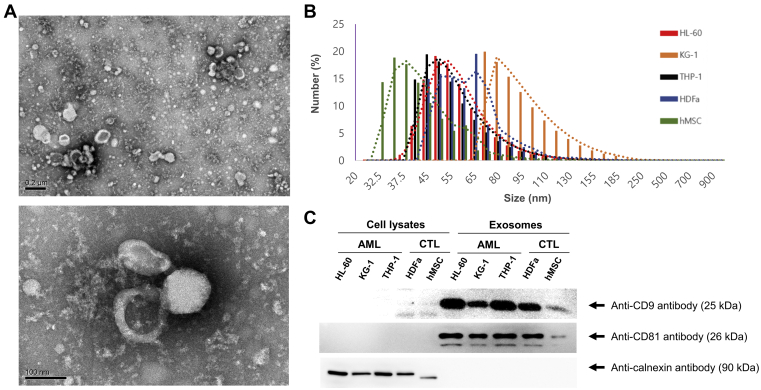
Validation of extracellular vesicles (EVs) derived from acute myeloid leukemia (AML) cells and control cells. A, in transmission electron microscopy, the size of the cell line–derived EVs was <200 nm. They were visualized as cup-shaped vesicles. B, dynamic light scattering revealed a size range of 30 nm to 185 nm. C, a total of 30 μg of each protein sample was separated using 10% SDS-PAGE. Western blot analysis showed that the isolated EVs were positive for the exosome markers (CD9 and CD81) but negative for the endoplasmic reticulum marker calnexin.